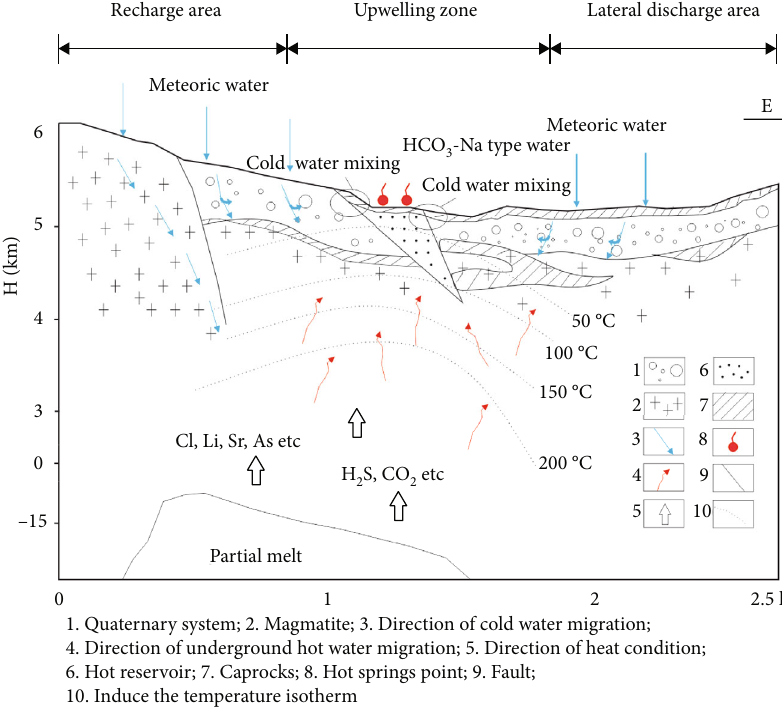
Figure 10: Concept model of the geothermal origin in the study